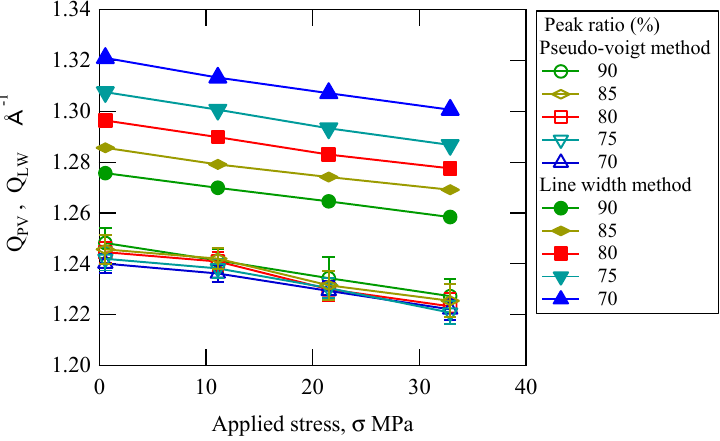
Figure 6. Relation between magnitude of the scattering vector and applied stress.